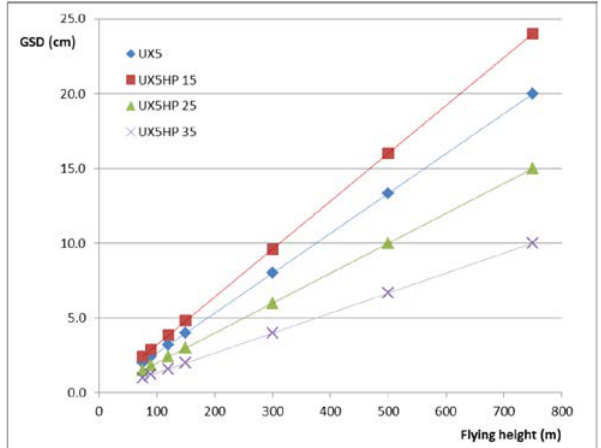
Figure 3: GSD in relation to flying altitude and based on different